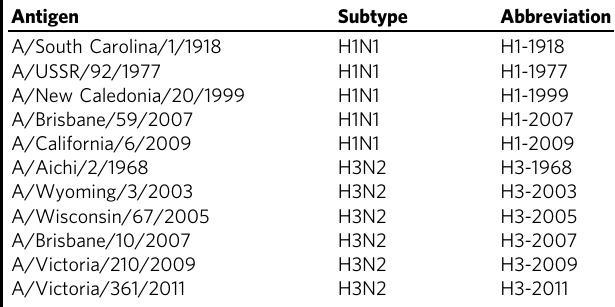
Table 1 HA1 antigens of 11 different human in fl uenza strains used for the